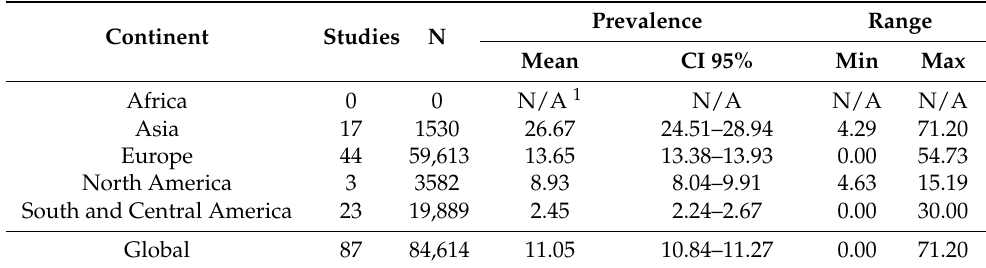
Table A4. Animal SLRV prevalence in each continent from 2011 to